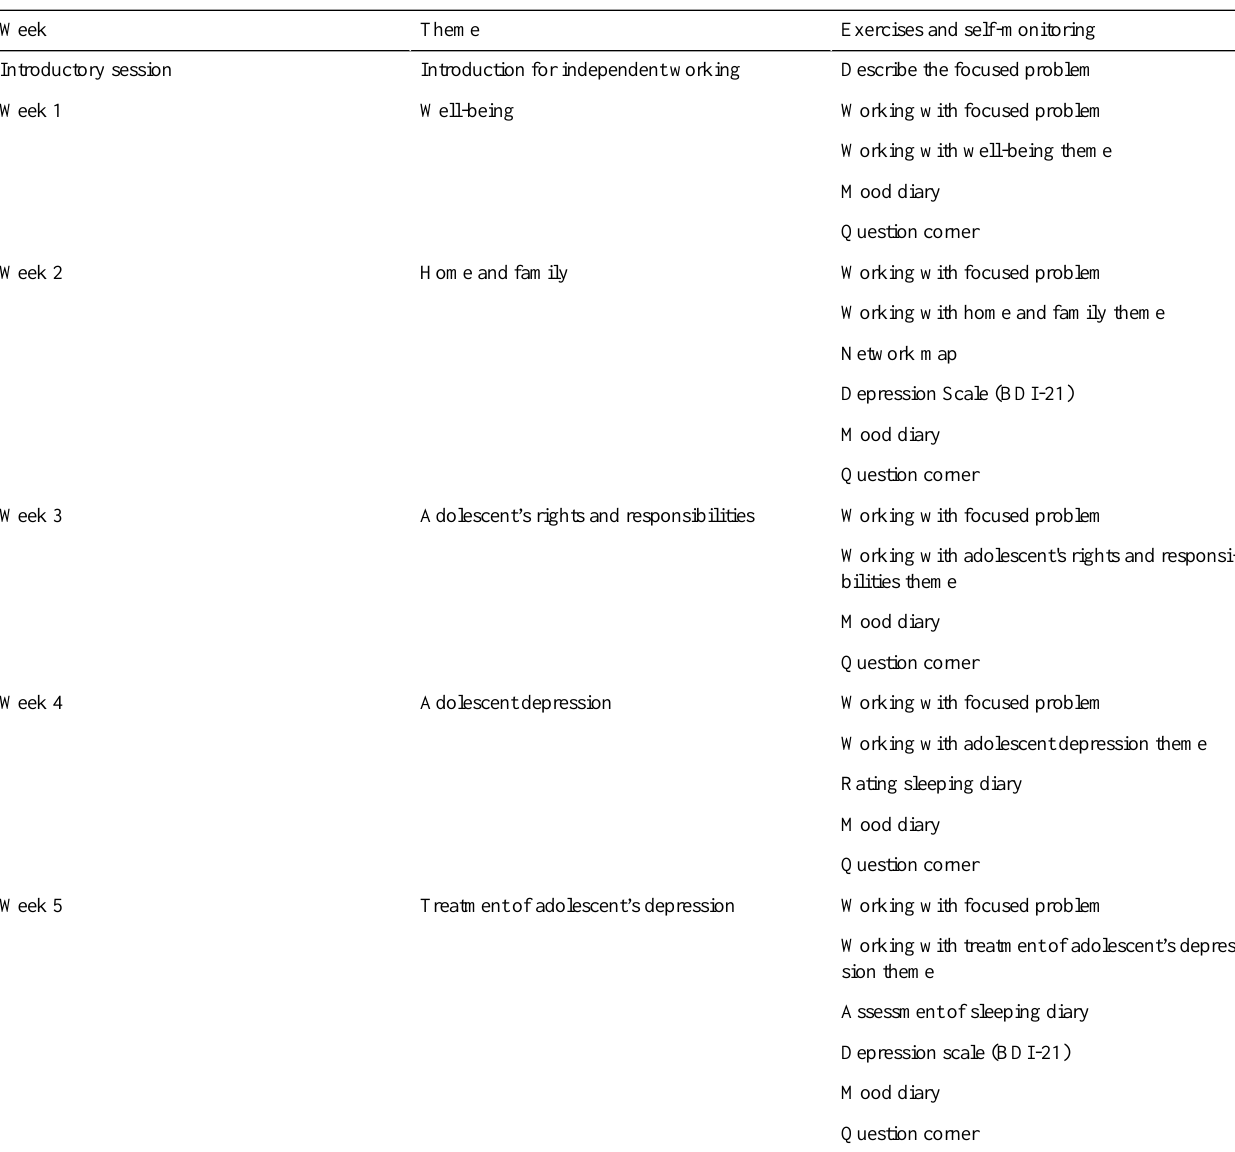
Table 2. Themes, exercises, and self-monitoring activities in the Internet-based support system.